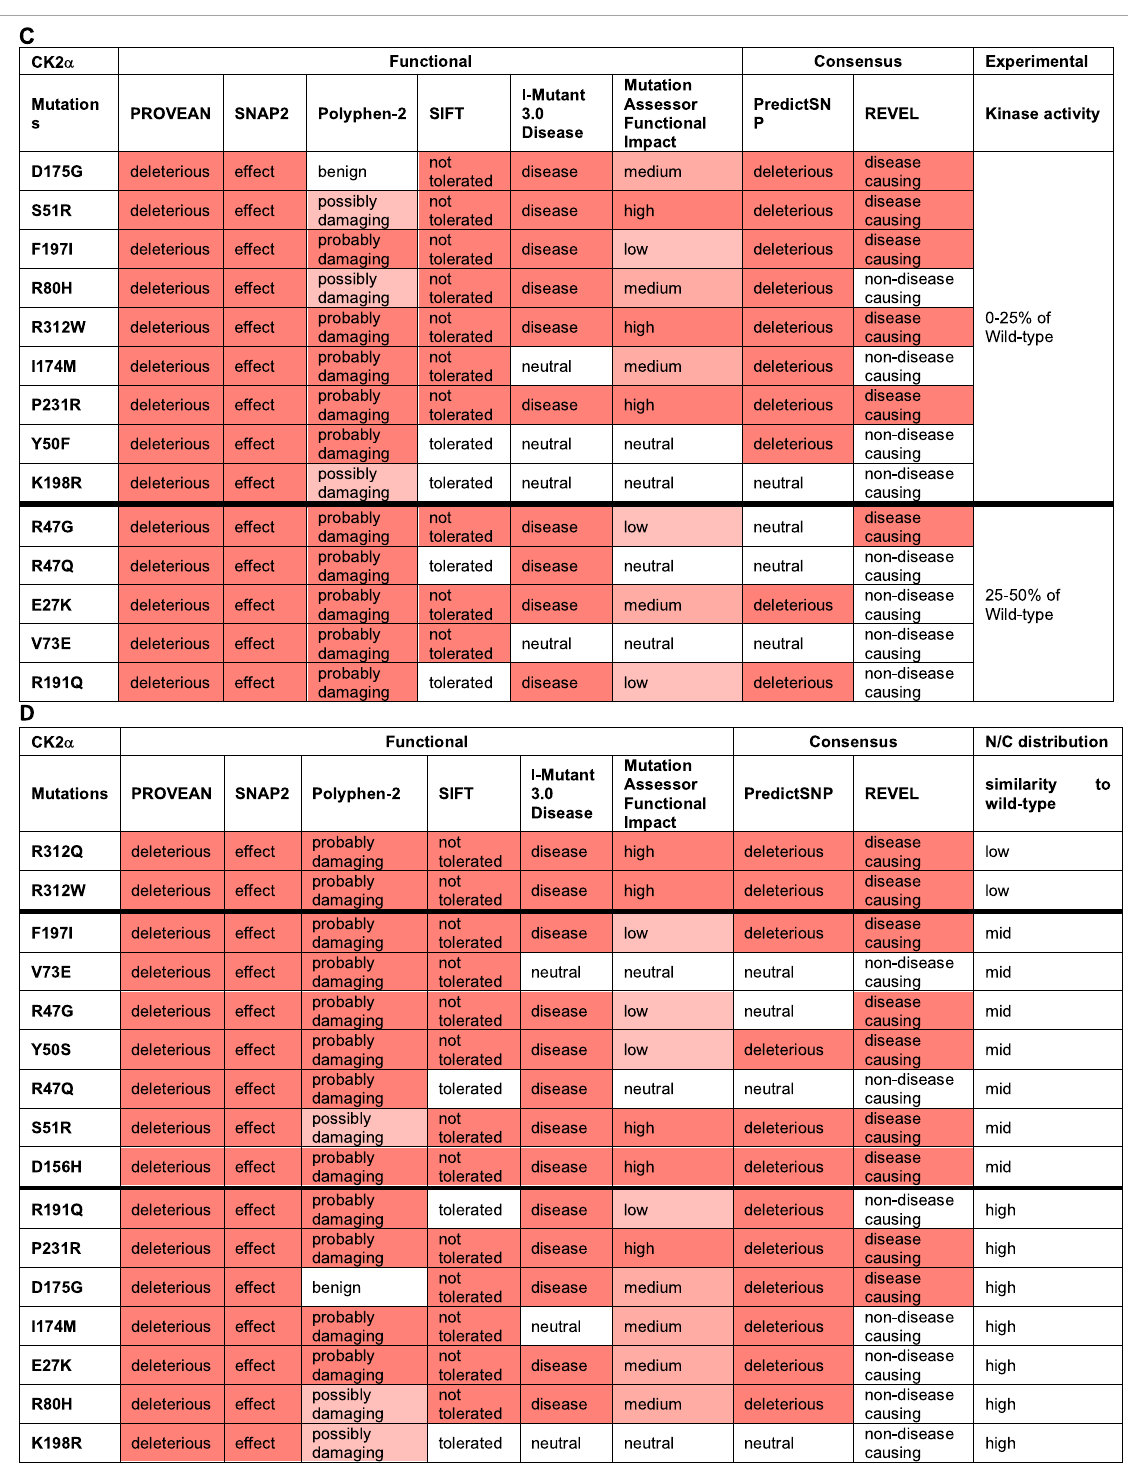
TABLE5AnalysisofCK2 α andCK2 β proteinmutations usingfunctionalpredictionprograms. PredictionsforCK2 α (A)and(B)CK2 β .Colorsinthecells re fl ect the effect from neutral (white) to high effect (red). The numbers obtained in the analysis can be found in Supplementary Table S4. (C, D) Comparison between CK2 α predictions and experimental data on CK2 α from Dominguez et al., 2021. (C) kinase activity of the recombinant CK2 α protein mutants puri fi ed from bacteria; from 0%to 25% (top rows) to 25% – 50% (bottom rows) compared to wild-type puri fi ed protein. (D)Degreeof similarity between nuclear/cytoplasmic localization CK2 α protein mutants to wild-type proteins expressed in cell lines; from low to high. N/A (= not applicable) indicates residues that could not generate a prediction. [Note: MutationAssessor has been down precluding us from analyzing 7 mutants, indicated with ( —